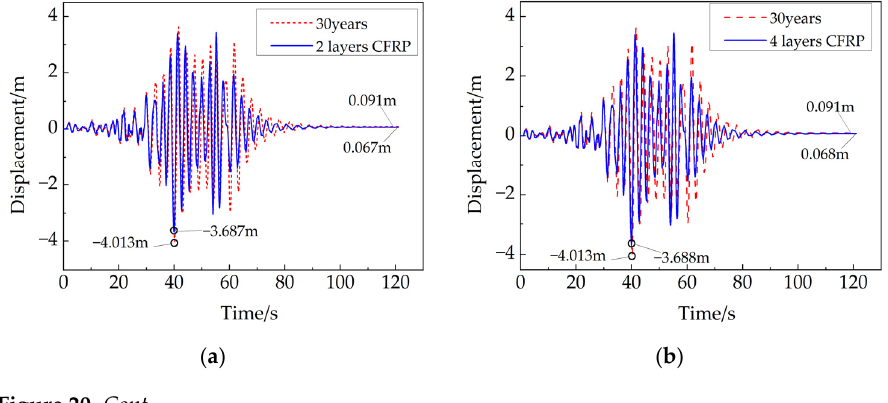
( d ) Figure 20. Comparison of different reinforcement conditions: ( a ) two-layer CFRP reinforcement; ( b ) four-layer CFRP reinforcement; ( c ) eight-layer CFRP reinforcement; ( d ) Comparison of structural residual deformation. It can be seen from Figure 21 that the main damage position of the structure that only strengthens the corrosion area is the upper tower, especially the top of the tower. This can also be obtained from the residual deformation of the structure. With the increase of CFRP layers, the damage degree of the steel pipe pile at the bottom of a wind power tower tends to increase. ( a ) ( c ) Figure 21. Structural stress cloud diagram: ( a ) two layer CFRP; ( b ) four layer CFRP; ( c ) eight layer CFRP.